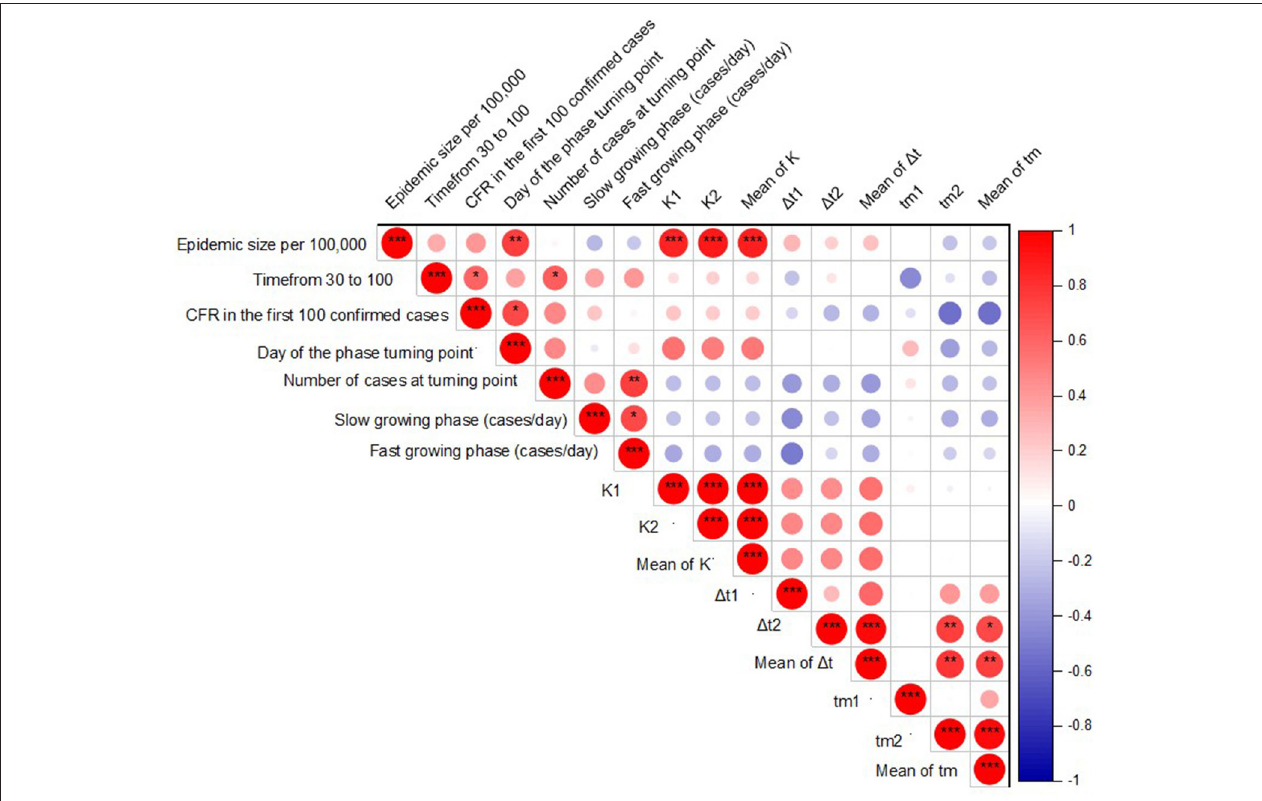
FIGURE 4 | Correlation between epidemic size, early stage of epidemic indicators, and bi-logistic parameters by Spearman’s correlation test. * p ≤ 0.05, ** p ≤ 0.01, *** p ≤ 0.001.